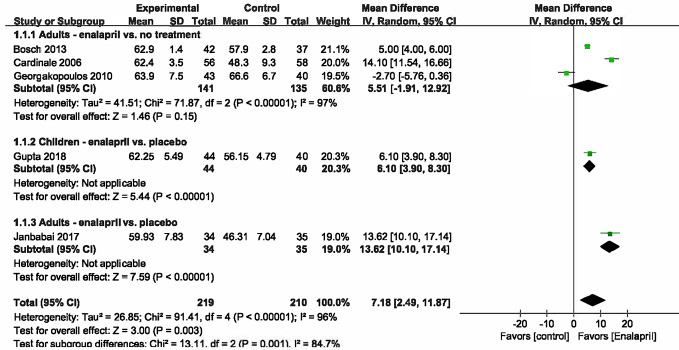
Meta analysis for LVEF value.